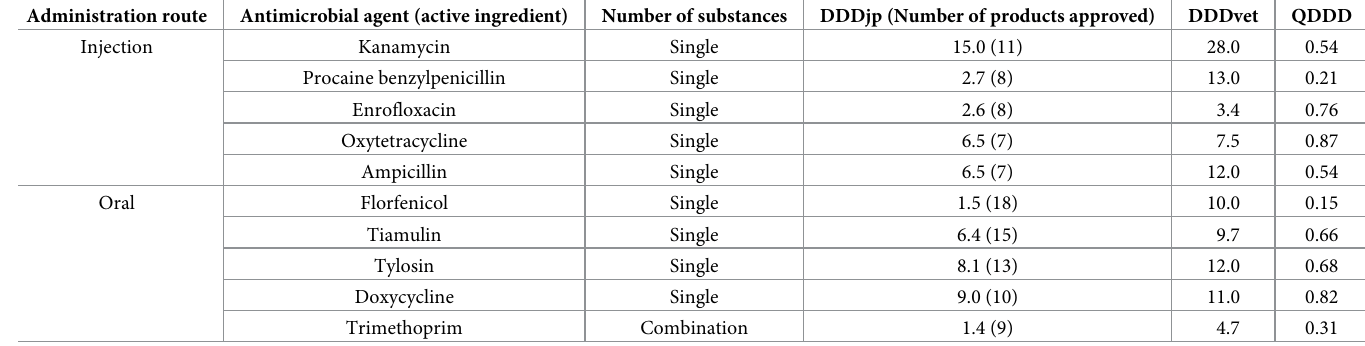
Table 5. Average daily doses (DDDjp) of the most frequently approved antimicrobial agents (divided by administration routes) for use in pigs in Japan and their comparison with the values of the European Medicines Agency (DDDvet) based on calculated quotients (QDDD). Administration